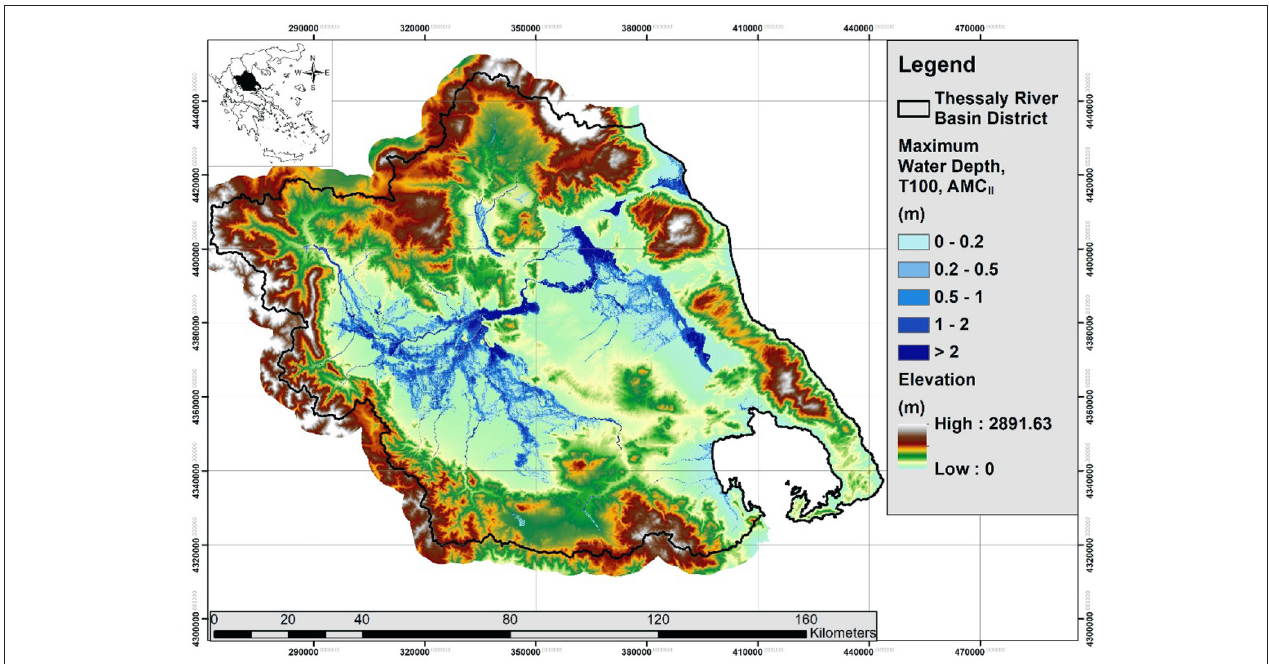
FIGURE 3 | Indicative results of 2-D flood ( T = 100) simulations for Thessaly (Adapted from: Papaioannou et al.,